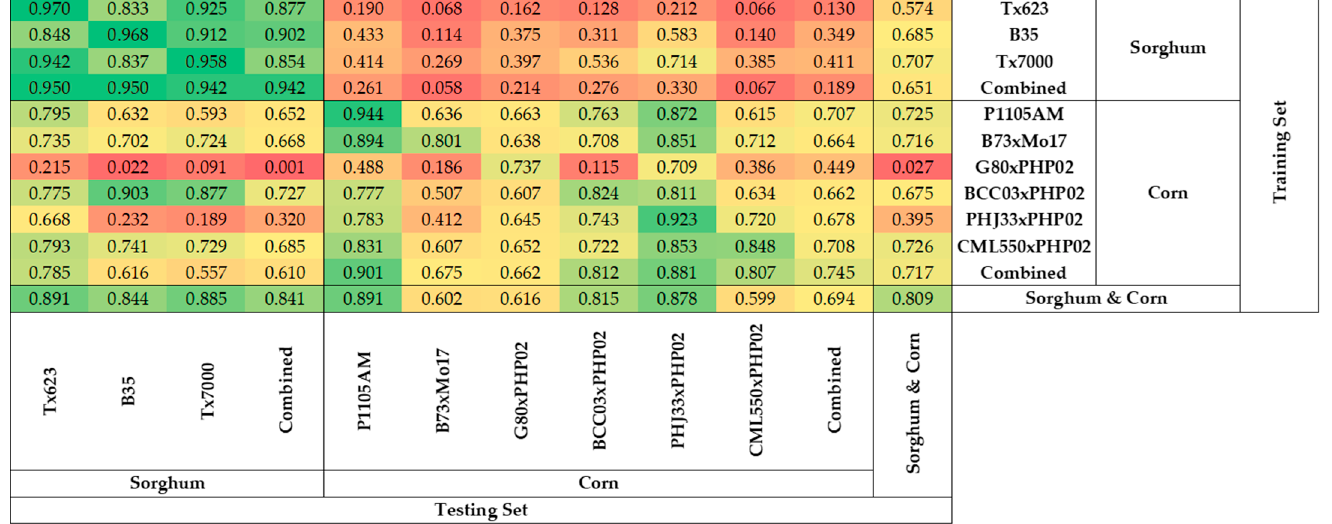
Figure 1. Heatmap of coefficients of determination of models predicting the relative water content of different genotypes with hyperspectral reflectance.